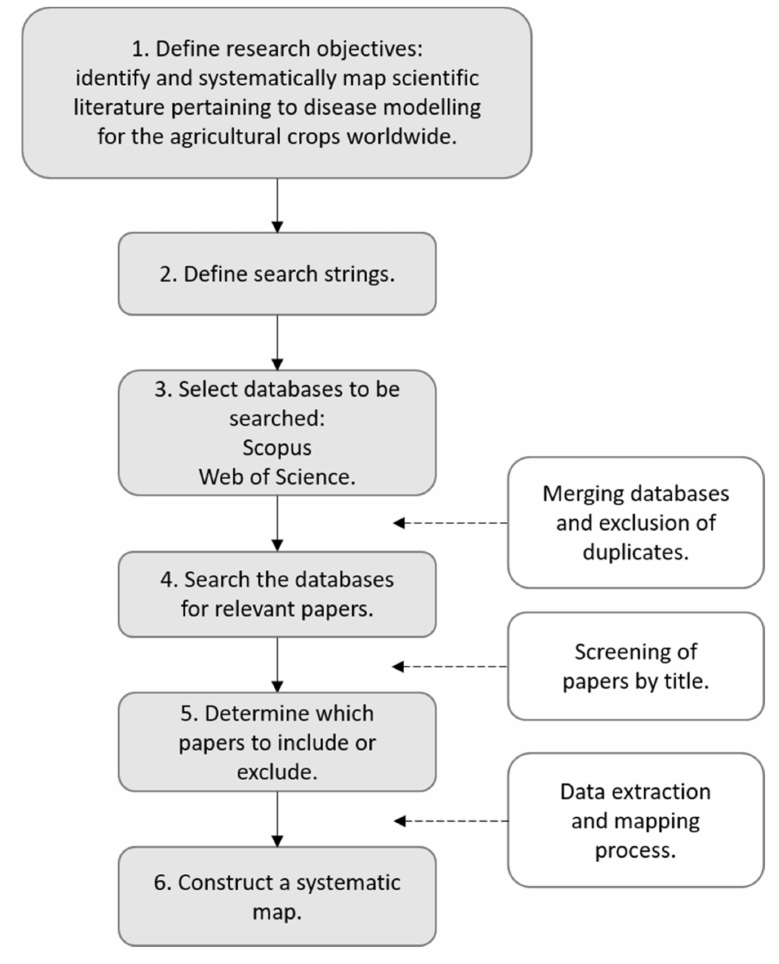
Figure 1. Steps for the development of the systematic map.